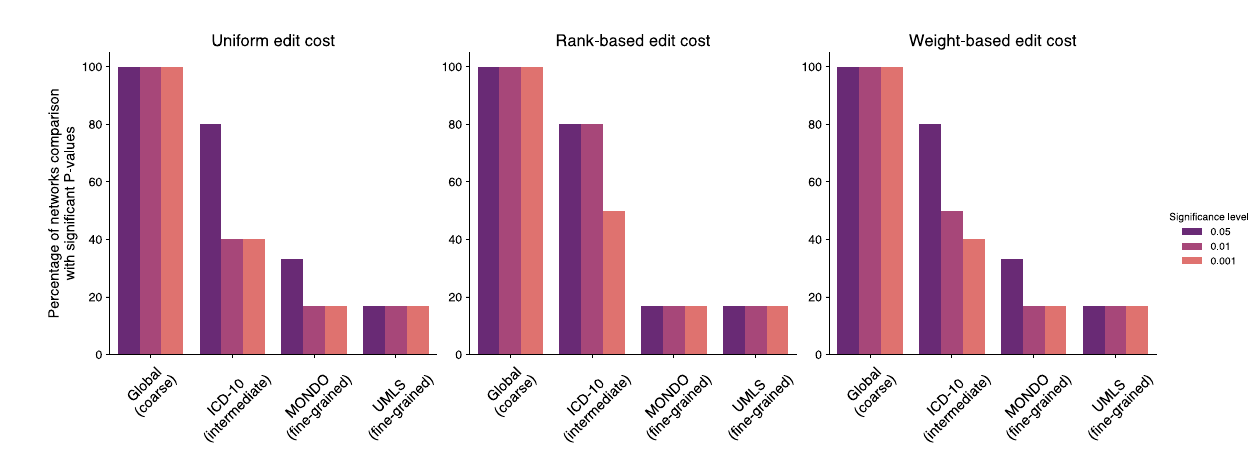
Fig. 8| Effect ofdiseaseterm granularity onresultsofGED-based analyses. Fortheindividual P -valuessummarized inthis fi gure,seeFig.6a,aswellasSupplementary Figs. 1, 4a, 5, 9, and